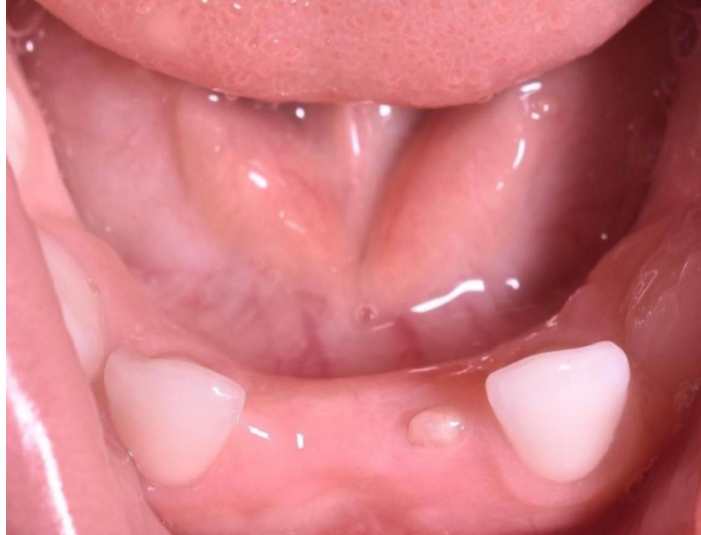
Figure 4. Clinical follow-up done after two years.